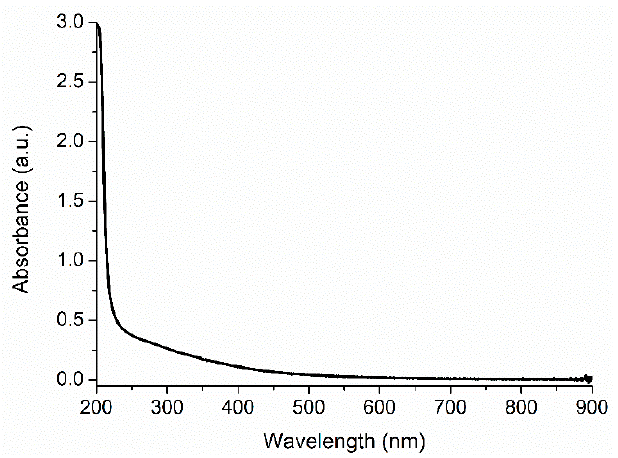
Figure 4. UV-VIS absorption spectrum in the 200–900 nm range of an aqueous solution containing 0.01 g L − 1 of BBS-HA.